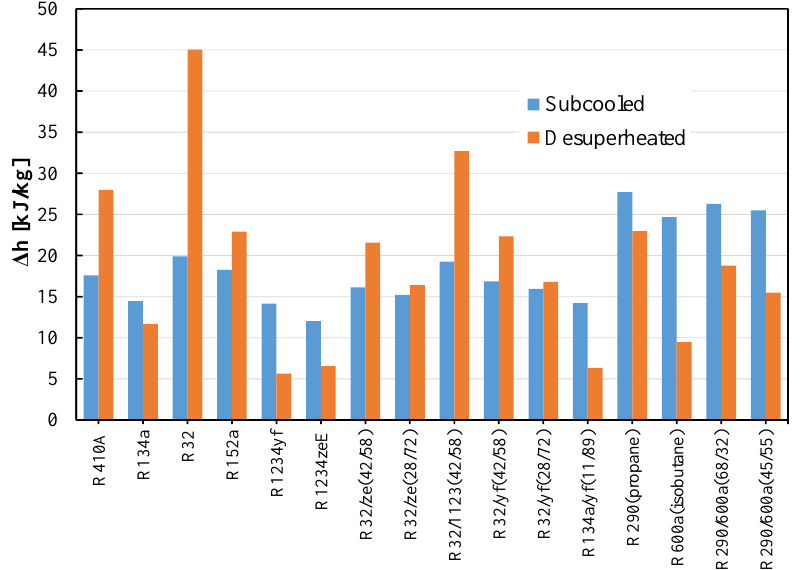
Figure 9. Subcooled and desuperheated enthalpy of pure and blended refrigerants.